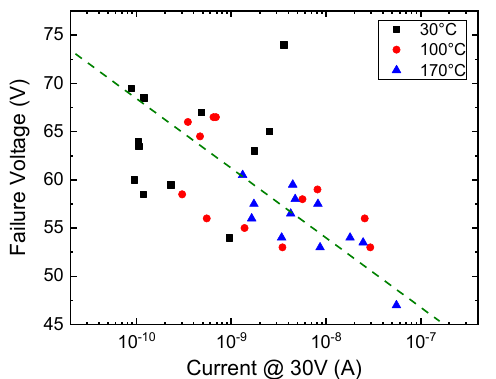
Figure 11. Failure voltage vs. leakage current measured at 30 V on sample A at di ff erent ambient temperatures.